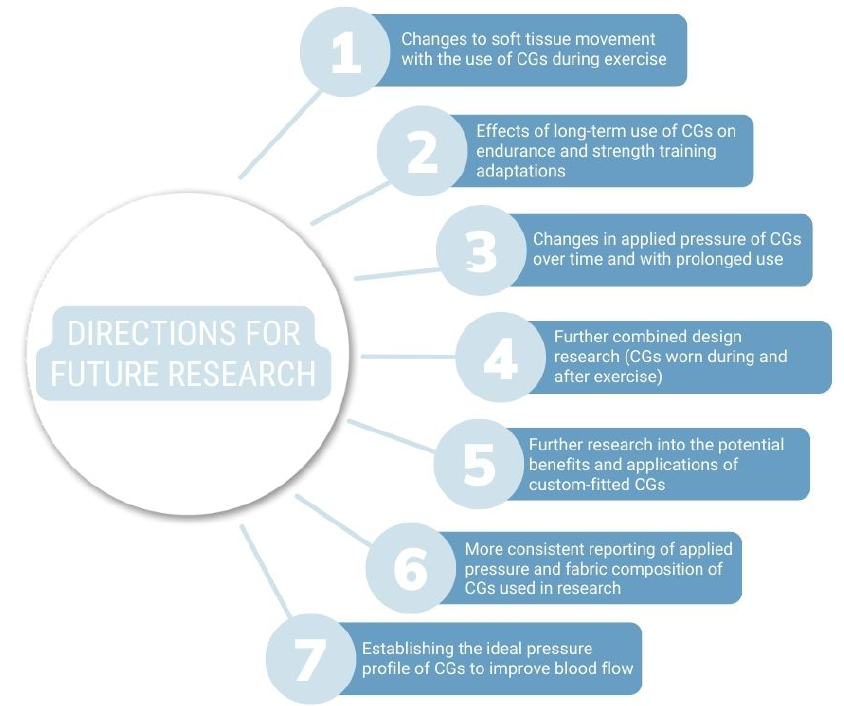
Figure 4. Suggested directions for future research based on the findings of the systematic review.